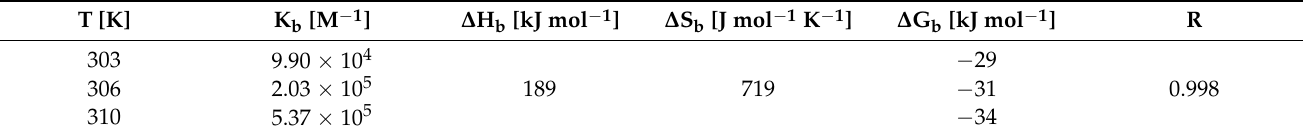
Figure 7. The fluorescence spectra of BSA after the addition of various amounts of 1 at ( a ) 30 °C; ( b ) 33 °C; ( c ) 37 °C; and ( d ) Van’t Hoff diagram for the binding process of 1 and BSA. Table 3. Thermodynamic parameters of binding of 1 to BSA at different